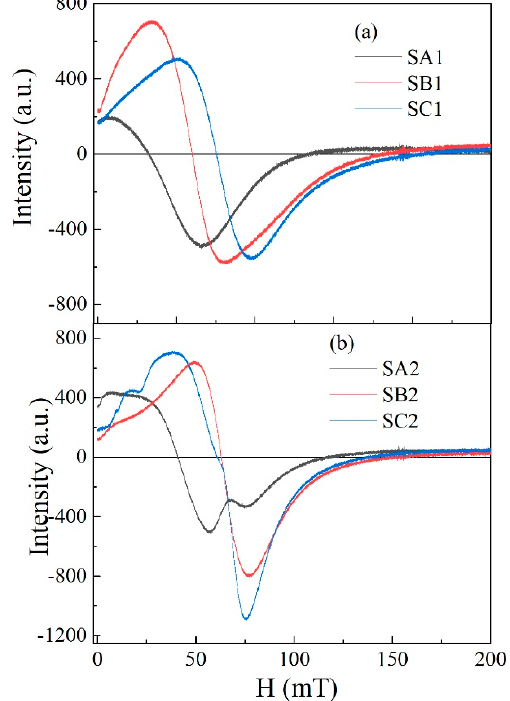
Figure 4. Ferromagnetic resonance (FMR) spectra of FeNi / FeGa (FeGa / FeNi) samples. ( a ) is the FMR image of SA1, SB1 and SC1, ( b ) is the FMR image of SA2, SB2 and SC2.